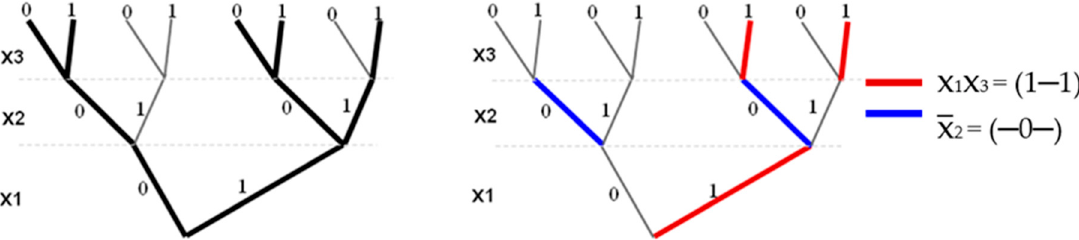
Figure 7. Traditional two-valued minimization.